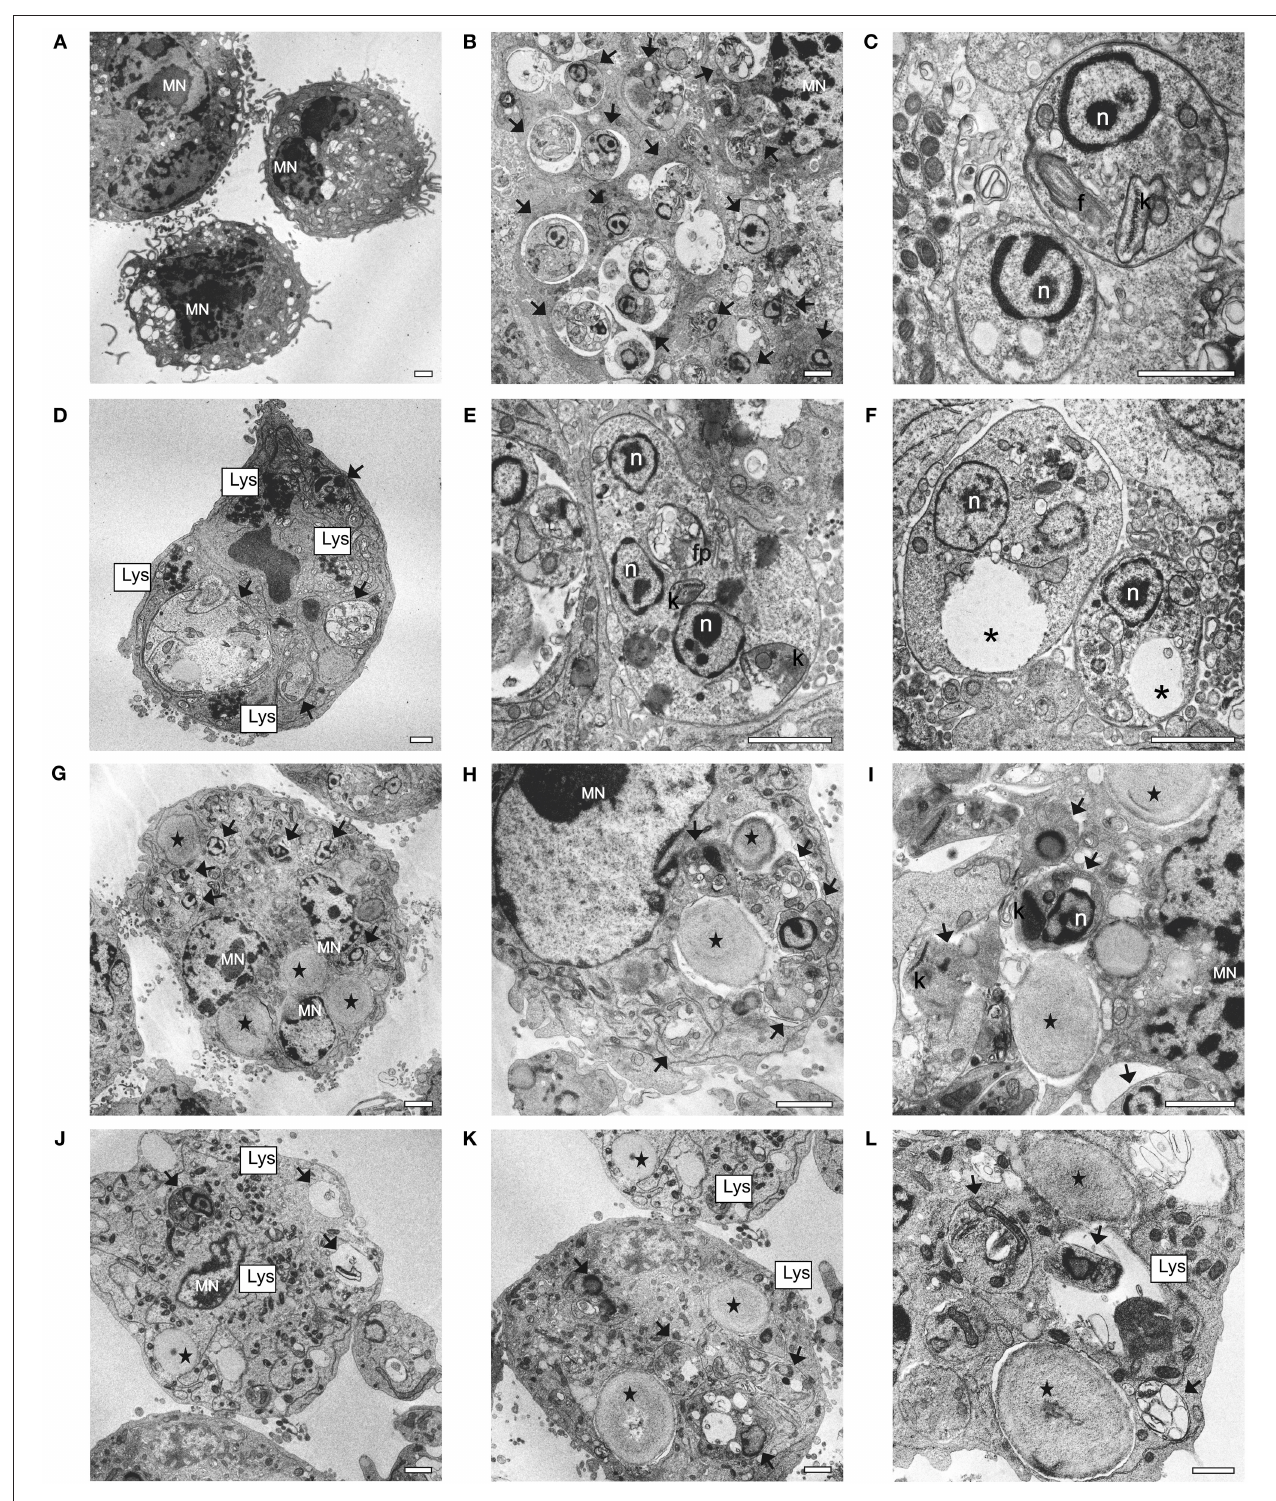
FIGURE 10 | Ultrastructural changes in macrophages and L. infantum amastigotes observed by TEM analysis. (A) uninfected and untreated macrophages; (B,C) infected macrophages; (D–F) infected macrophages treated with 5.7 µ g/mL of sugiol; (G–I) infected macrophages treated with empty YCWPs at 1 mg/mL; (J–L) infected macrophage treated with 1 mg/mL of YCWPs containing 7 µ g/mL of sugiol. (MN) macrophage’s nucleus; (black arrows) amastigotes; n, amastigote’s nucleus; f, flagellum; k, kinetoplast; Lys, lysosomes; fp, flagellar pocket; *vacuole; (black star) YCWPs (scale bar = 1 µ m).